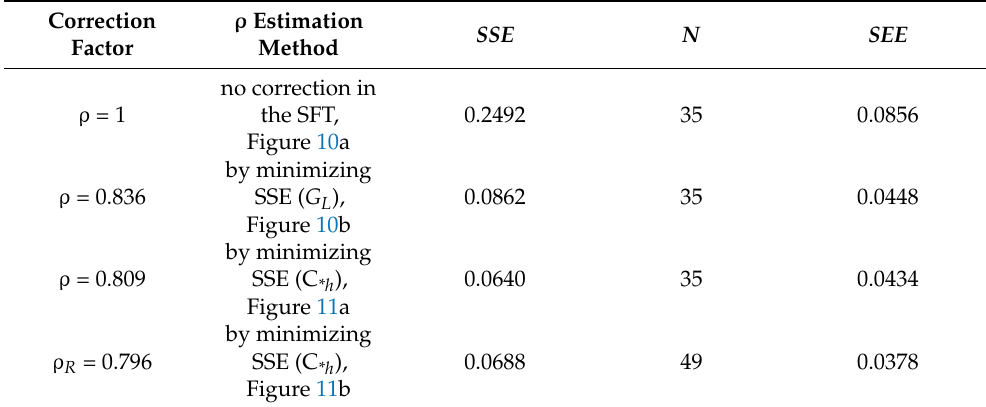
Figure 9. ( a ) Standard error on the estimate, SEE , between the experimental limiting normalized solid flux, G * , obtained by data of d’Antonio and Carbone [34], and the corresponding theoretical values (Equation (24)) versus the limiting solid flux reduction factor ρ . ( b ) Comparison between measured and calculated G *L for the minimum SEE value, SEE min , obtained for ρ = 0.836, for different k x 0 values. Table 4. Sum square error, SSE ; sample size, N ; and standard error of the estimate, SEE , for different values of the reduction hydrodynamic